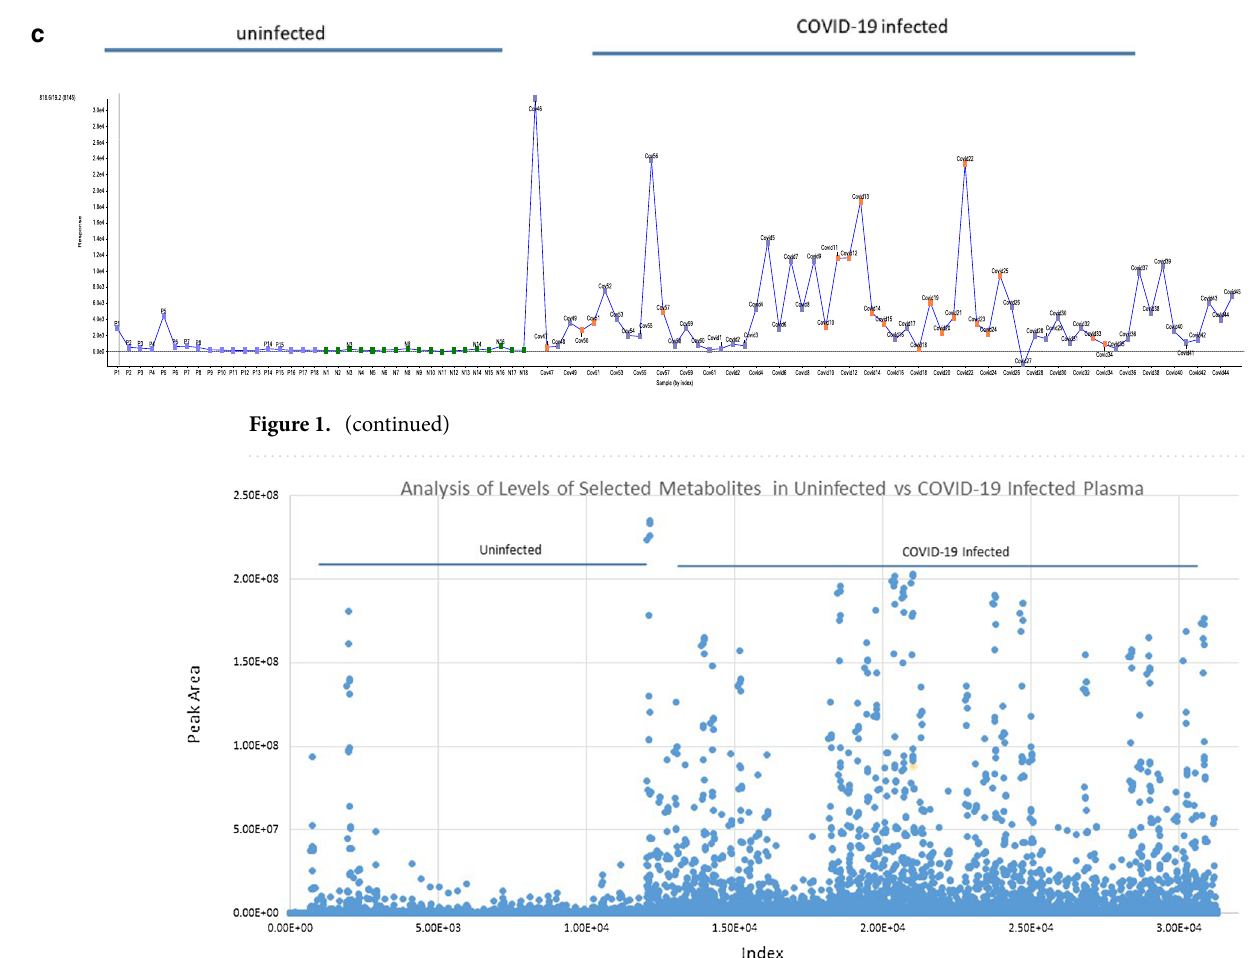
Figure 2. COVID-19 infection and abundance of selected metabolites. A comprehensive over view of levels, as measured by peak area, of metabolites in COVID-19-infected and control samples as measured by LC–MS/MS IDA analysis utilizing the m/z inclusion list provided from the loading component of PCA analysis. Each spot represents a metabolite as defined in the inclusion list, the Y axis represents the peak area detected for each m/z ion across the analyzed uninfected and COVID-19-infected samples X-